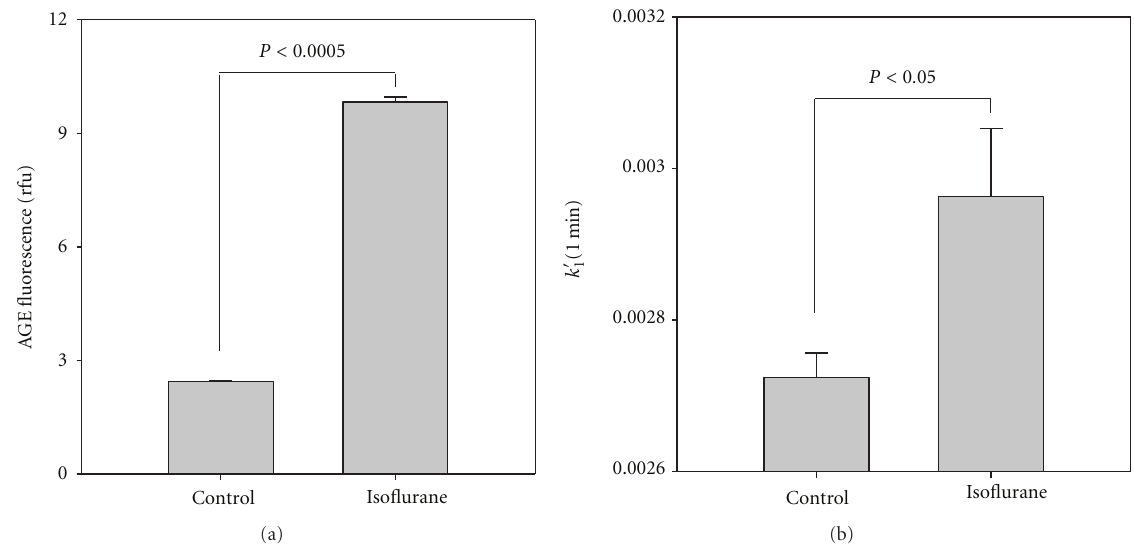
Figure 4: Isoflurane increases surface residue modification. HSA was treated with isoflurane prior to dilution and analysis of MG-induced formation of AGEs (a) and NPA-induced acetylation (b). The measurements were delayed and indicate an isoflurane-induced e ff ect that was not labile. Data are presented as mean values ± SD from 2–4